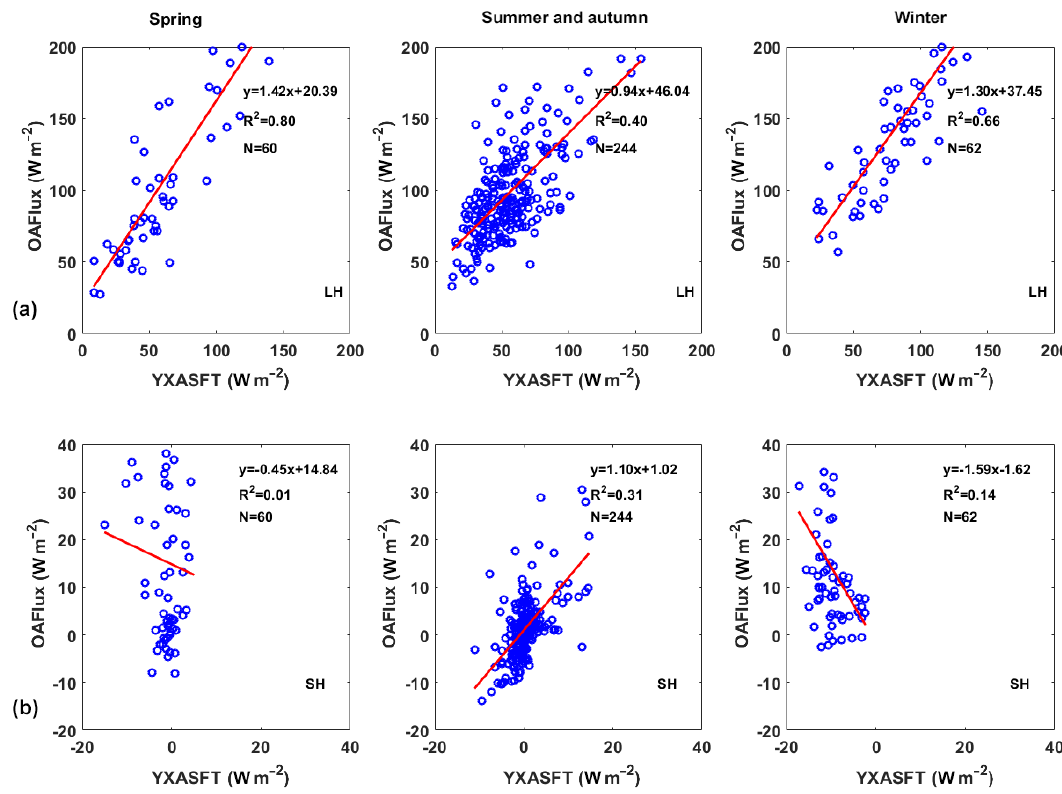
Figure 9. Same as Fig. 5 but for LHF (a) and SHF (b)